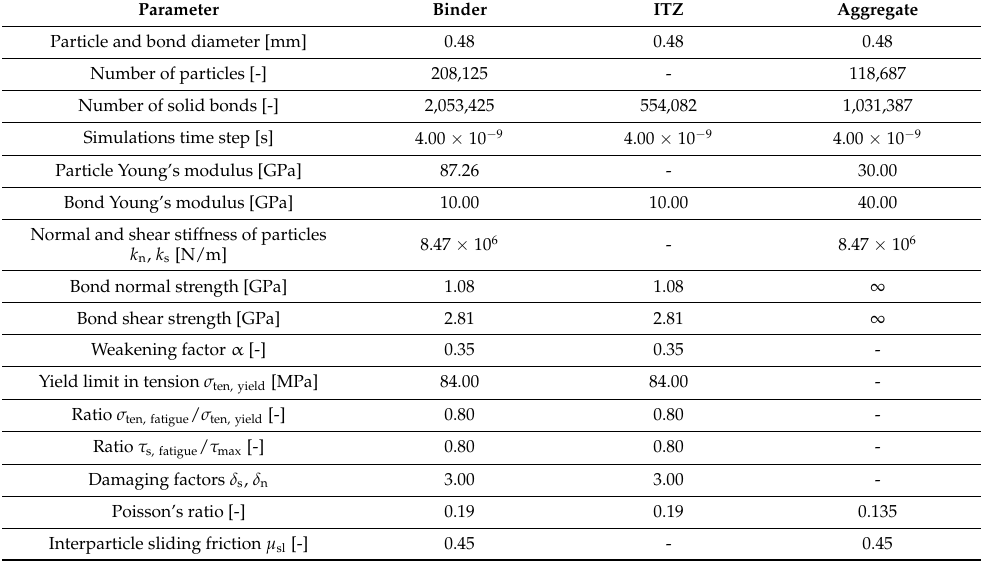
Table 4. Main material parameters of the BPM model after calibration with static experiments.